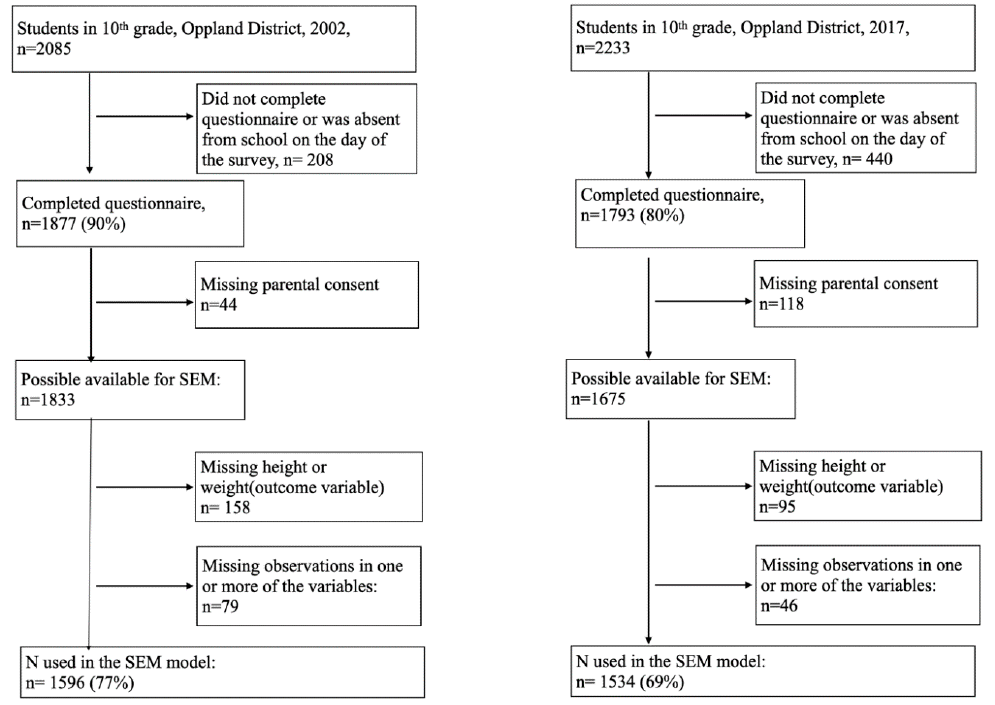
Figure 1. Flowchart of study-sample.